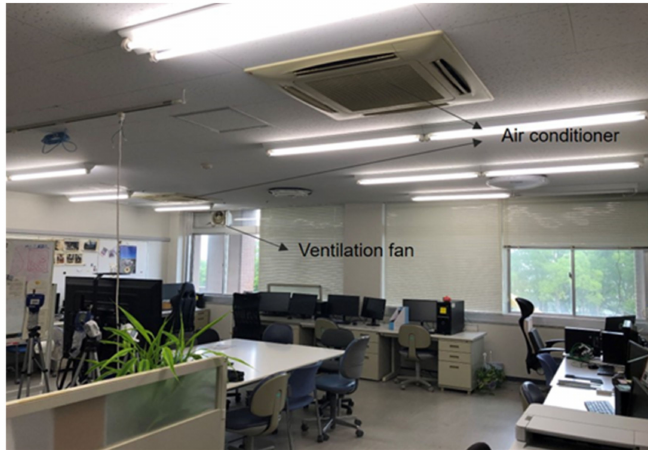
Figure 1. Photograph of measurement scenery.